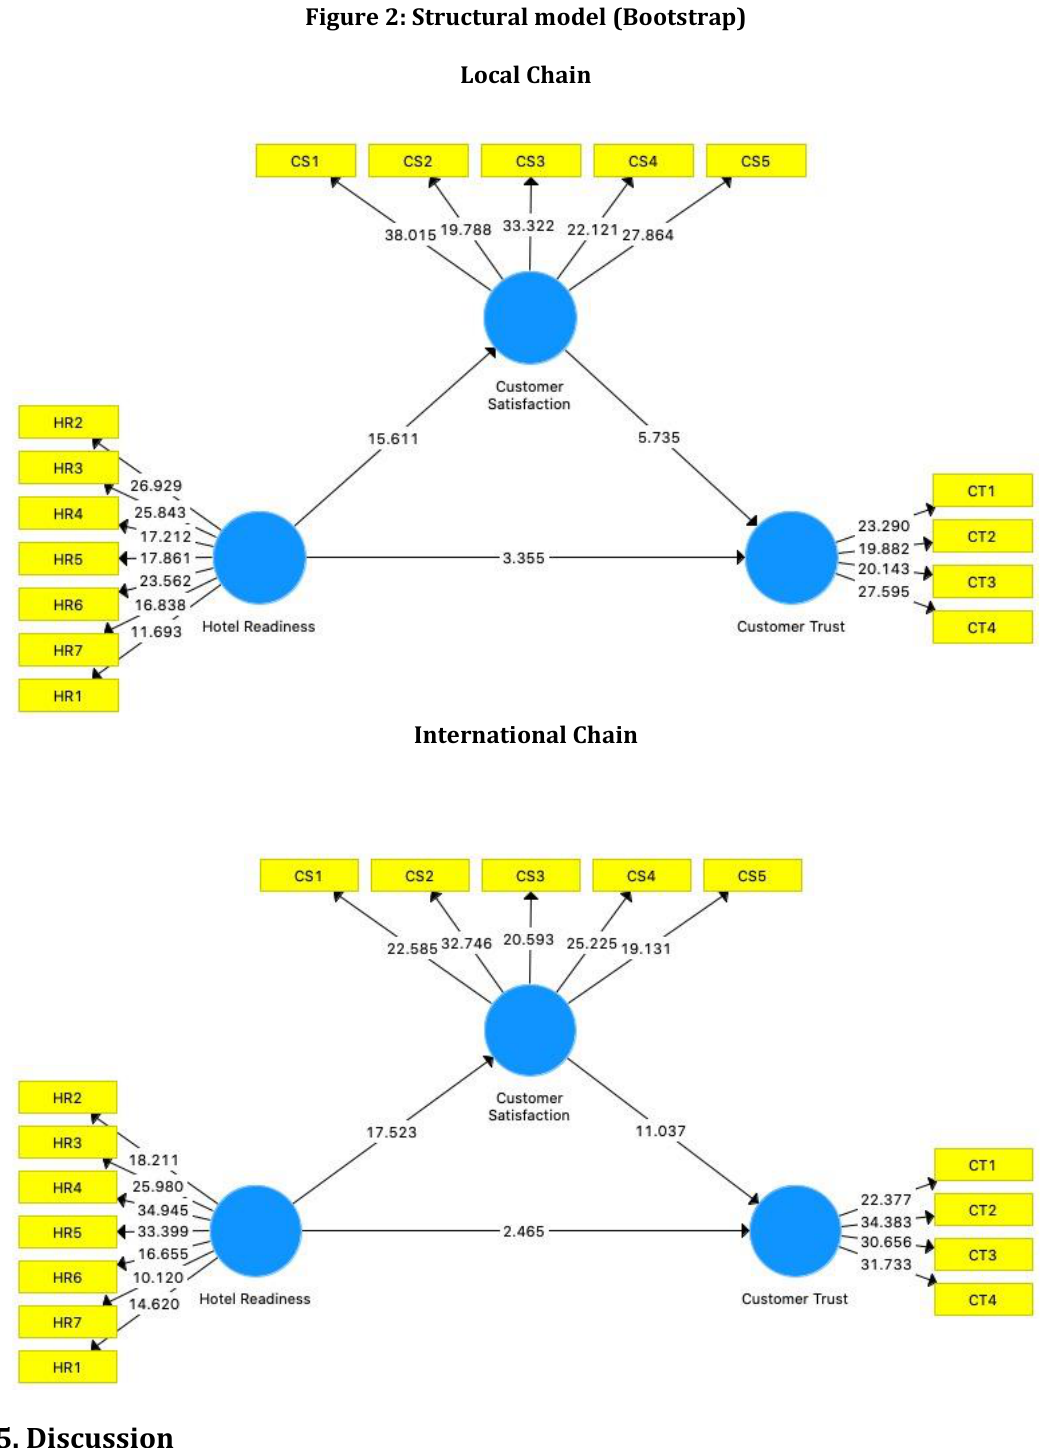
Figure 2: Structural model (Bootstrap) Local